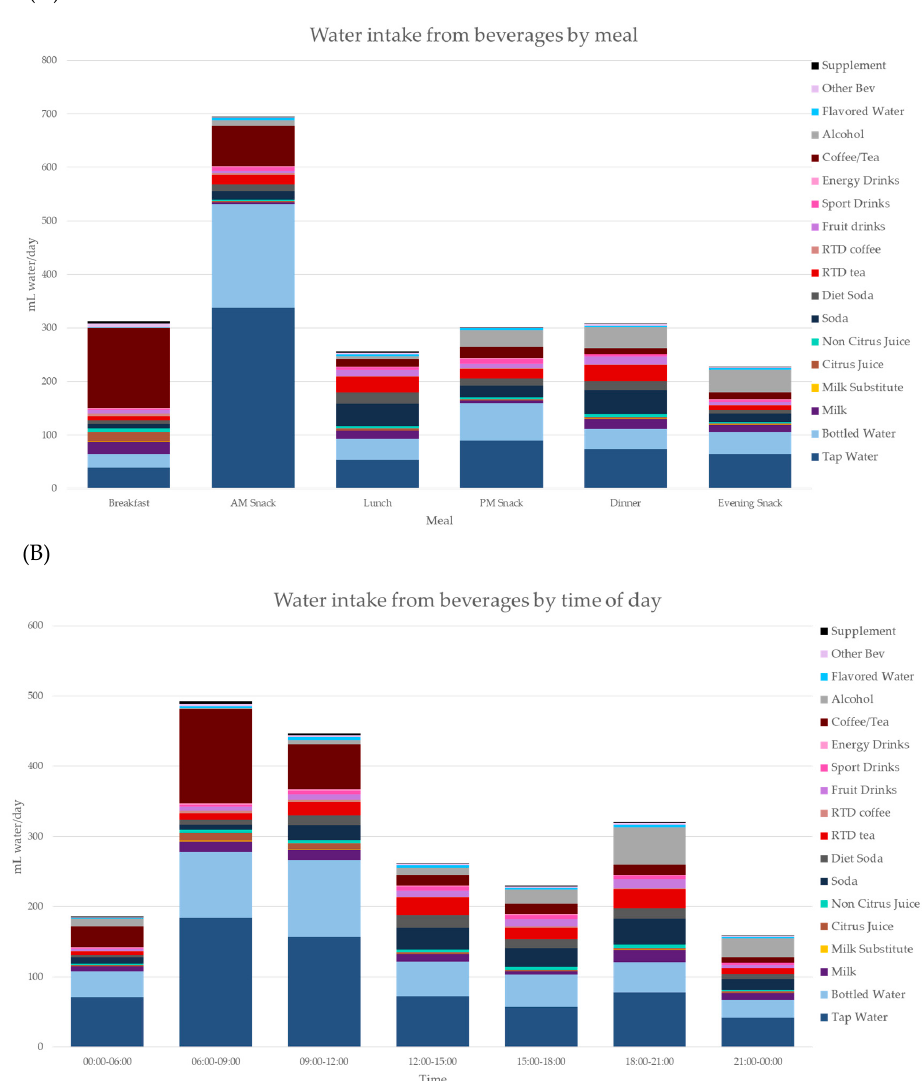
Figure 2. ( A ) (top panel) Water intakes from water and beverage categories by eating occasion. ( B ) (bottom panel) Water intakes from water and beverage categories by time of day. Data are for participants >4 y.